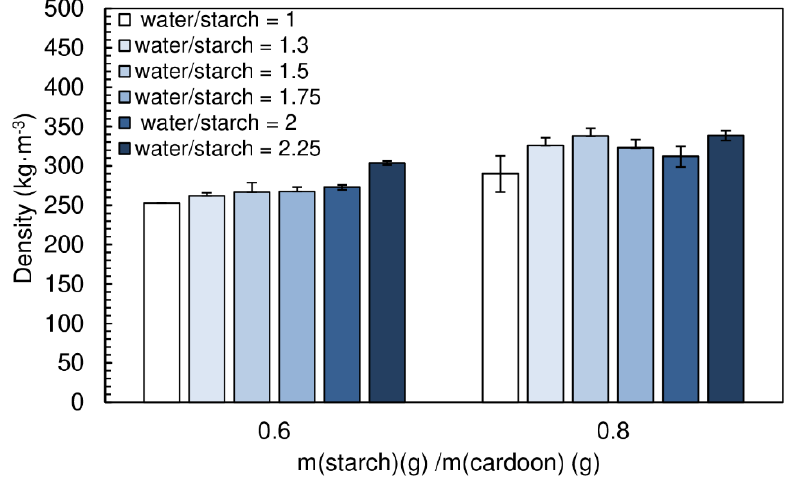
Figure 12. Density of the particleboards produced with different water/starch ratios. All adhesive formulations had a starch/cardoon ratio of 0.6 and 0.8 and cs/starch ratio of 0.05.